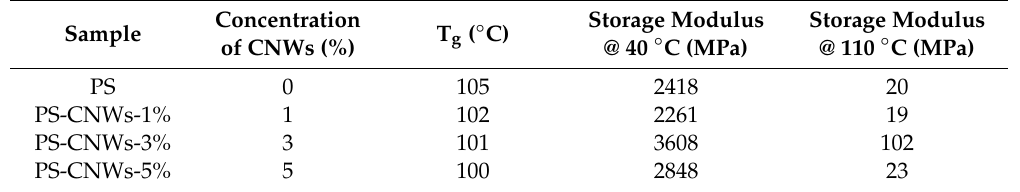
Figure 11. Diagrams of ( a ) storage modulus (E’) and ( b ) loss factor (tan δ ) of the nanocomposites and the pristine material. Table 2. Values of glass transition temperature (T g ) and storage modulus at 40 ◦ C and 110 ◦ C, of the nanocomposites PS-CNWs with di ff erent addition rate and the